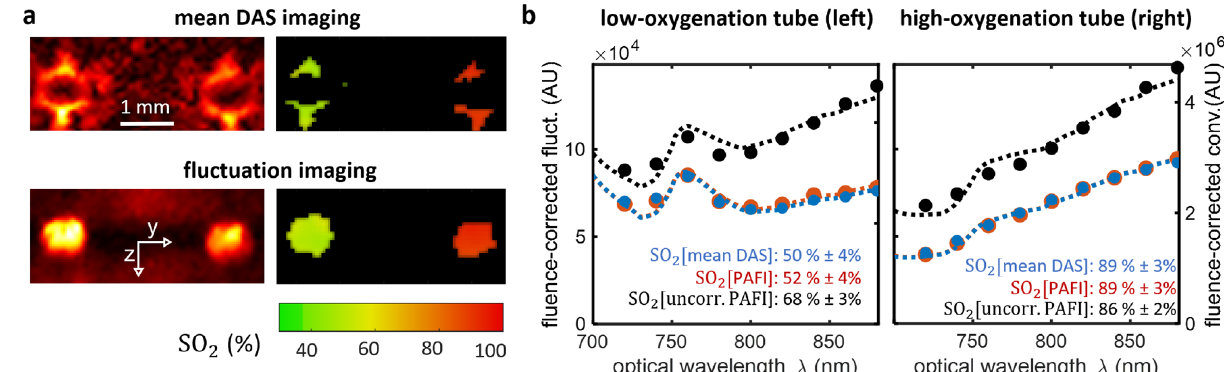
Figure 3. In vitro validation of multispectral photoacoustic fluctuation imaging (MS-PAFI) through a non- scattering medium. ( a ) 2D cross-sectional photoacoustic images of transparent capillary glass tubes (10 µ m wall thickness) filled with flowing blood at two different oxygenation levels. Top row: DAS photoacoustic imaging. Bottom row: MS-PAFI. MS-PAFI provides the same quantitative SO 2 values as conventional DAS photoacoustic imaging, but without visibility artefacts. ( b ) Relative spectral dependence of µ RBC ( (cid:31) , r ) estimated over the regions of interest (ROIs) indicated in ( a ): blue, red and black estimates are respectively for conventional DAS PA imaging, PAFI and uncorrected PAFI (without noise subtraction). The dashed lines represent the model curve that best fits the MS-PAFI data, leading to the fit-estimated SO 2 value. ± values for SO 2 are the spatial standard deviation computed over the ROIs (the ROIs correspond to regions were SO 2 values were